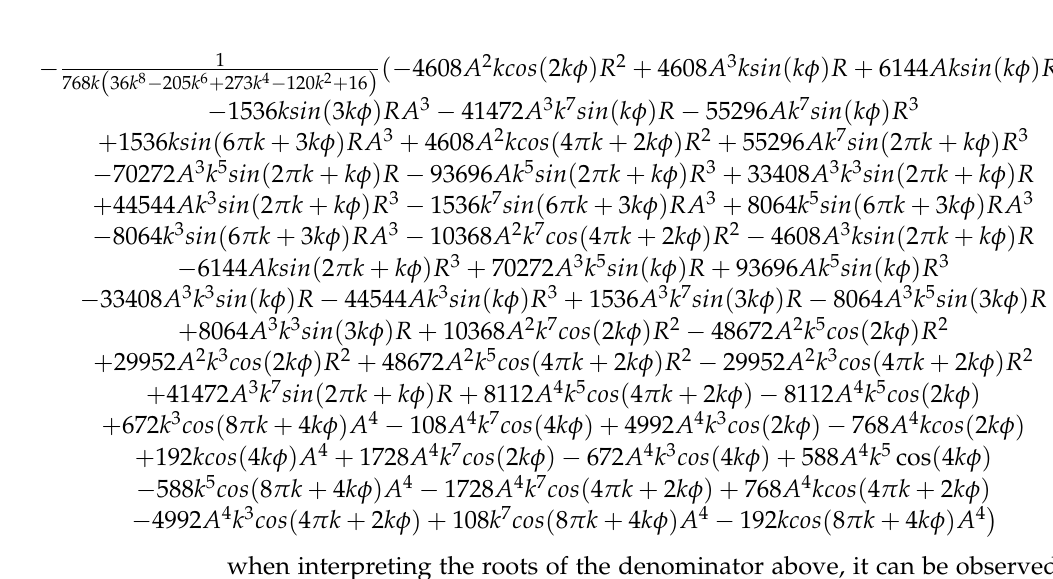
Figure A1. Derived second moment of area as a function of phase angle and component number.